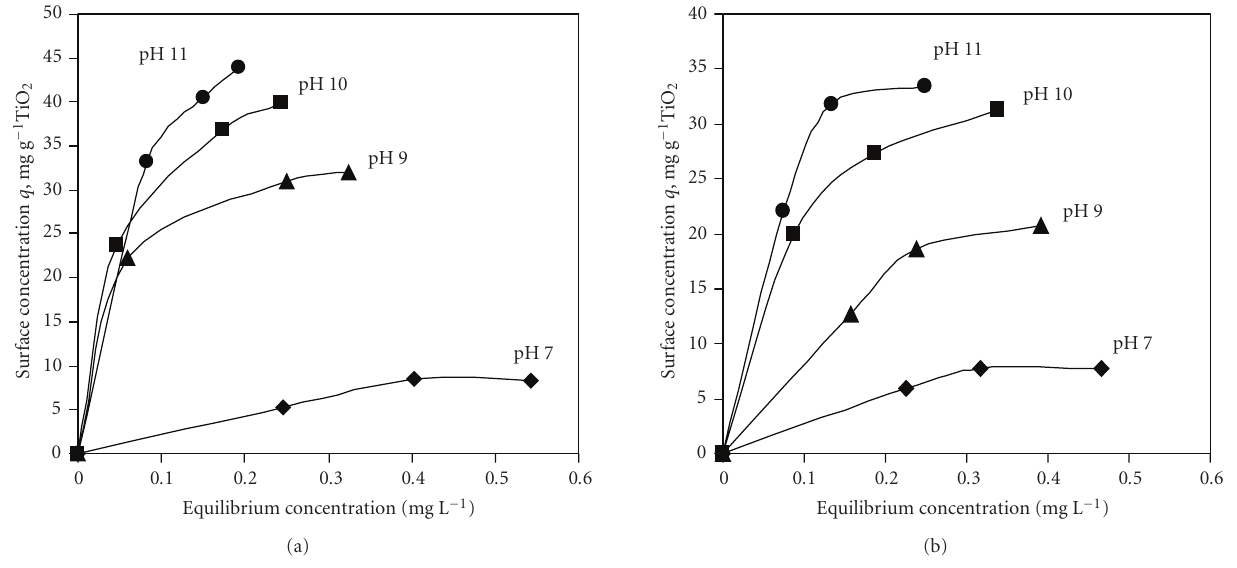
Figure 3: Adsorption isotherms for E2 (a) and EE2 (b) on TiO 2 catalyst surface at di ff erent pH values without co-pollutant.